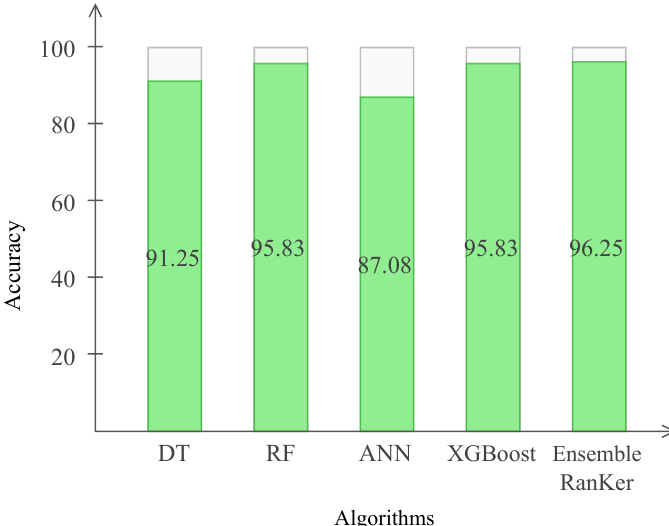
Figure 10. Comparison of current traditional ML approaches with proposed approach RanKer .